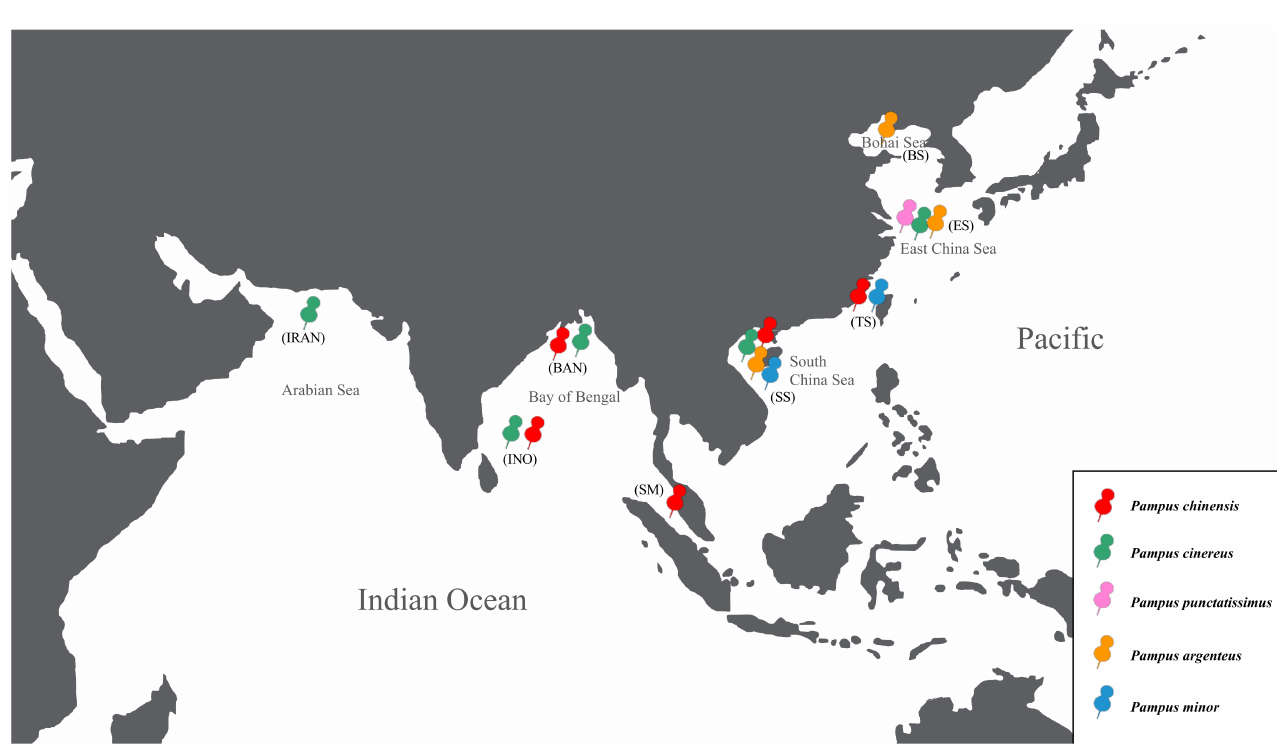
Figure 1. Geographic sampling locations for Pampus species used in this study; pins with different colors represent different Pampus species. Abbreviation of sampling site is in